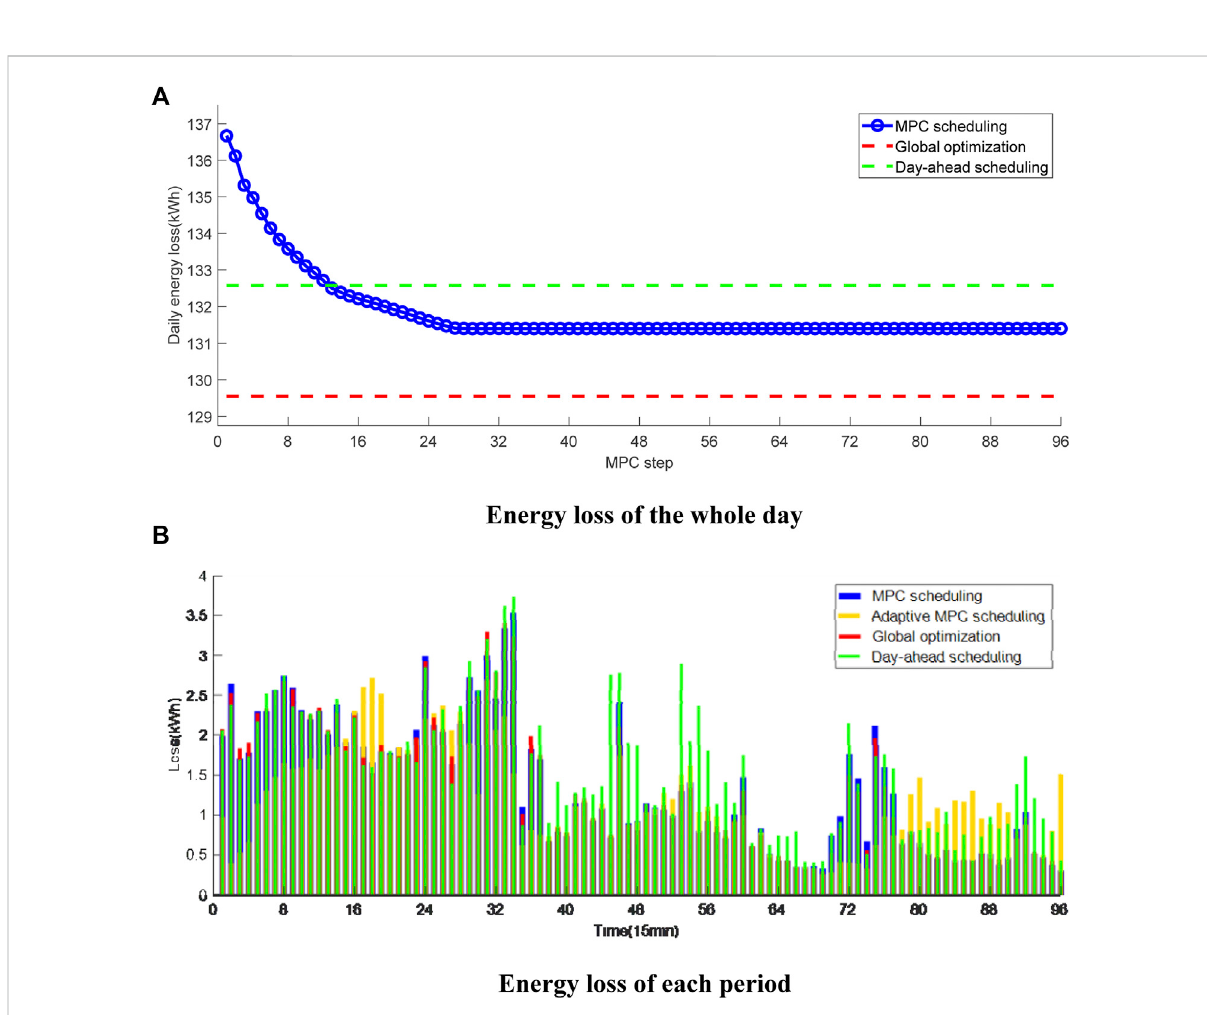
FIGURE 9 Energy loss of the LVDN under different scheduling strategies. (A) Energy loss of the whole day. (B) Energy loss of each